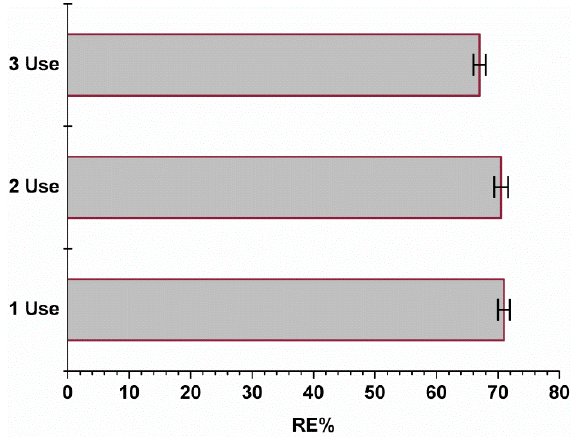
Figure 3. Bisphenol A removal efficiency, RE%, during regeneration and reuse of FF. Experimental conditions: fiber loading = 1 g; water volume = 50 mL; C 0 = 15 mg/L; pH = 5; contact time = 60 min.